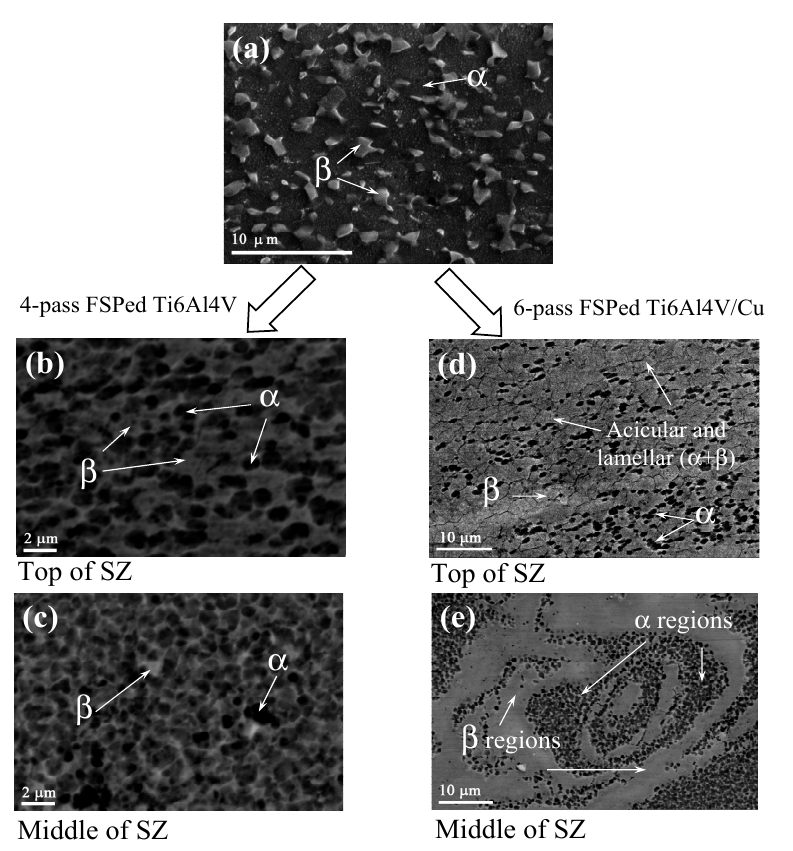
Figure 5. SEM BSE images of ( a ) as-received, ( b , c ) 4-pass FSPed Ti6Al4V, and ( d , e ) 6-pass FSPed Ti6Al4V/Cu microstructures. α and β are polymorphic phases of Ti.